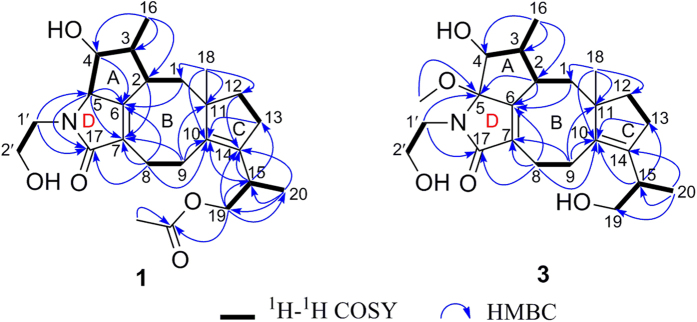
Key 1H-1H COSY and HMBC correlations of 1 and 3.